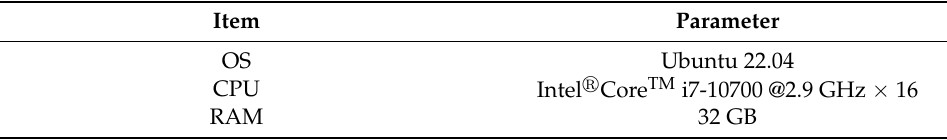
Table 3. Parameters of the experiment